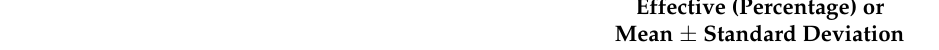
Table 2. Sample description (N =